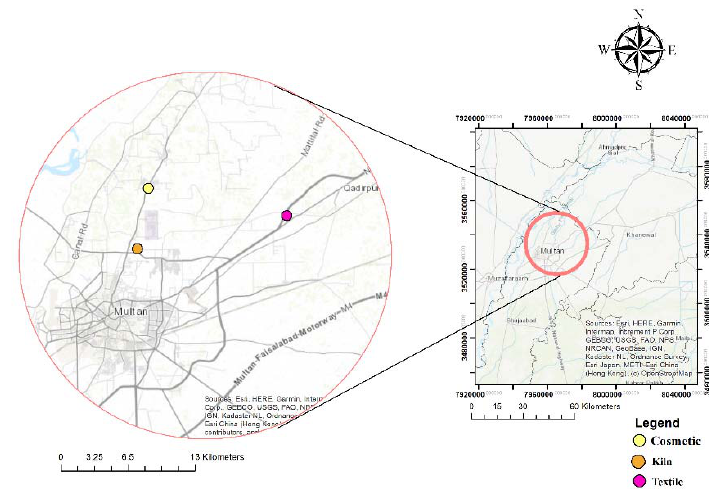
Figure 1. Map of the study